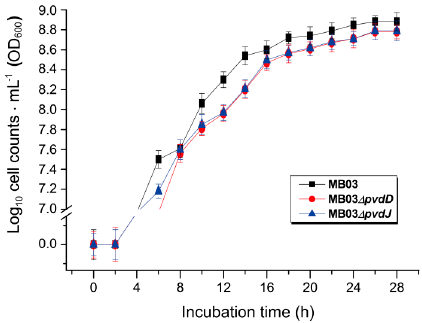
Figure 5. The growth curves of P. syringae MB03 and the mutant strains MB03 ∆ pvdD and MB03 ∆ pvdJ : MB03 and its derivatives were grown in M9 media for 28 h.